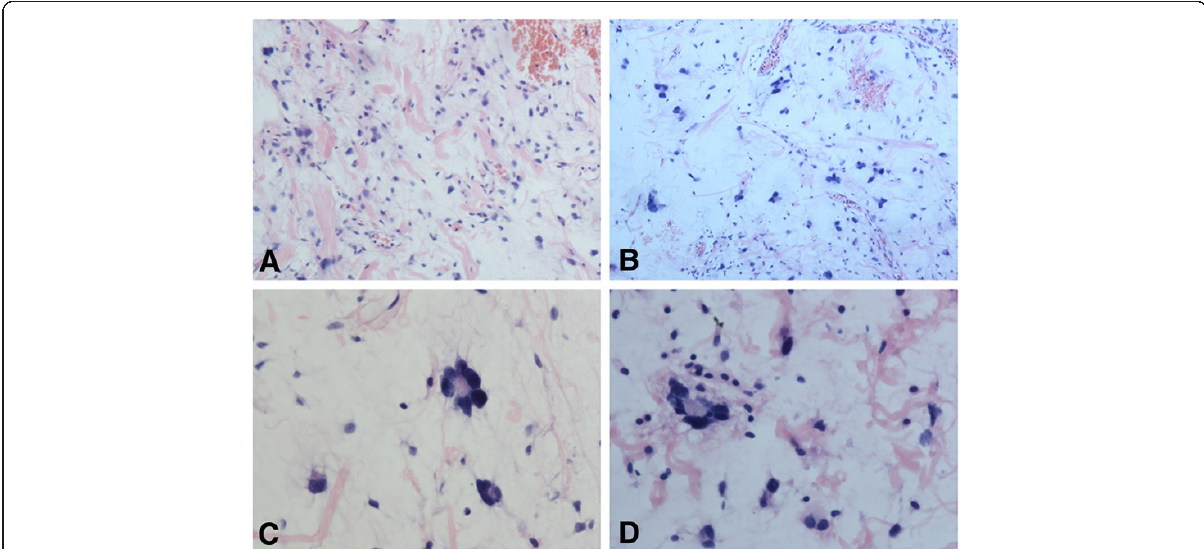
Figure 1 A, The tumor predominantly consists of spindle cells admixed scattered multinucleated cells and abundant ropey collagen. B , Foccally, in striking myxoid stroma, the cells are scarcely diffused, and the vascular pattern varies from plexiform to dilated intermediate-sized vessels. C , The multinucleate cells have hyperchromatic, pelmorphic and florte-like muclei. D , Scattered inflammatory cells, such as lymphocytes and plasma cells could be seen in myxoid stroma.